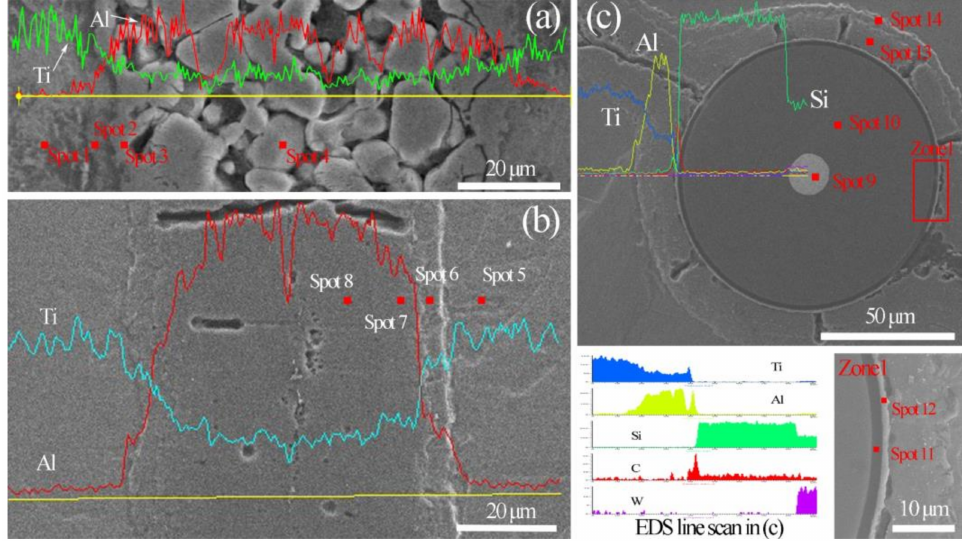
Figure 10. EDXS results: ( a ) Ti/Ti–Al laminated composites, ( b ) SiC f -reinforced Ti/Ti–Al laminated composites, and ( c ) SiC f /Ti–Al